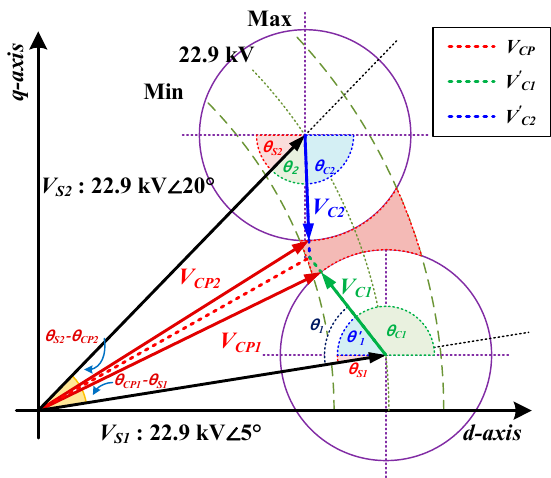
Figure 10. Vector diagram of the distribution line when the maximum output voltage of the APC is exceeded (when the phase of V S1 is not 0°).